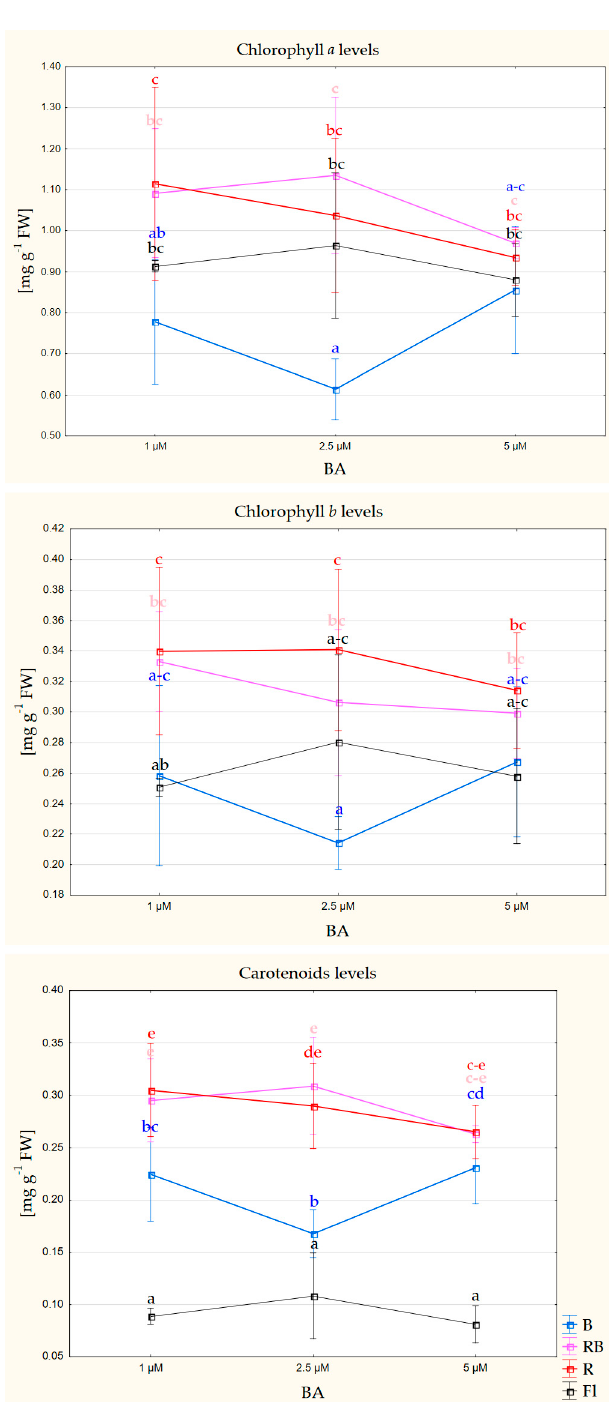
Figure 6. The level of photosynthetic pigments in gerbera leaves multiplied for 6 weeks under different quality of light (B — 100% blue LED; RB — mixed red and blue LED (7:3); R — 100% red LED; Fl — control, white fluorescent lamp) and different concentrations of BA in the medium; mean values are presented with standard deviation bars; columns followed by the same letter are not significantly different according to Duncan’s multiple range test at p ≤ 0.05. Table 3. Map of the correlations between the level of photosynthetic pigments and other investigated parameters of gerbera leaves grown under different qualities of LED light and in the media with different concentrations of BA.